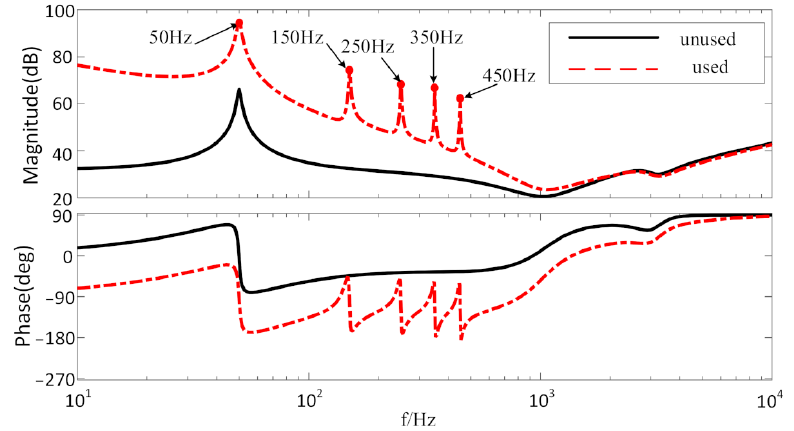
Figure 16. Bode diagram of output impedance used or unused combined harmonic suppression strategy.